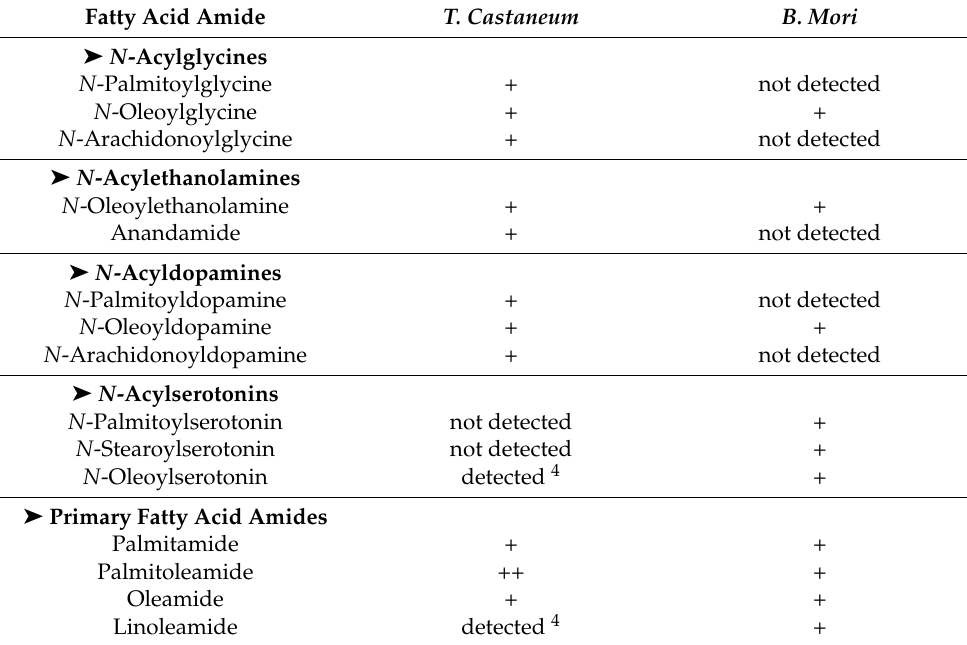
Table 4. Fatty acid amides produced by Tribolium castaneum 1,2 and Bombyx mori 1,3 . Fatty Acid